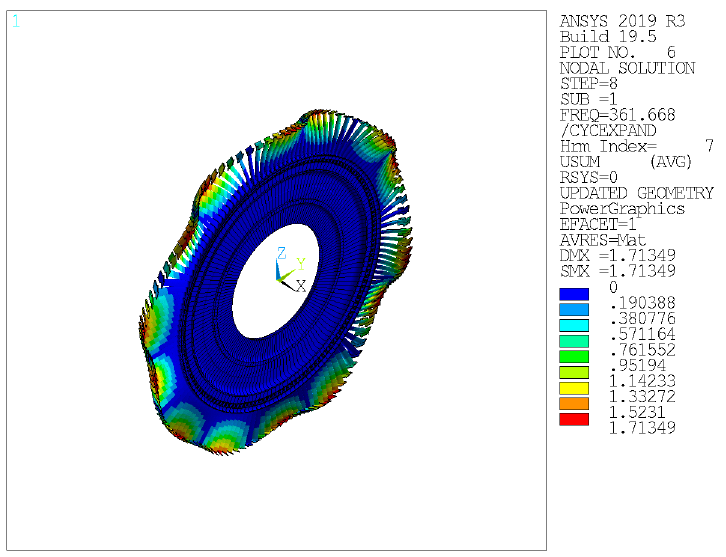
Figure 8. Modal displacements for ND = ± 7 of the 1st bending